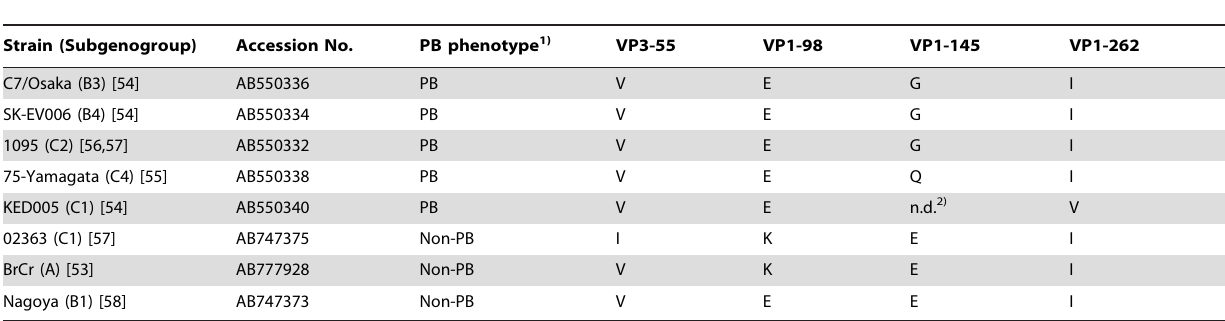
Table 1. Representation among EV71 isolates of the four amino acids found to differ between KED005 and 02363.